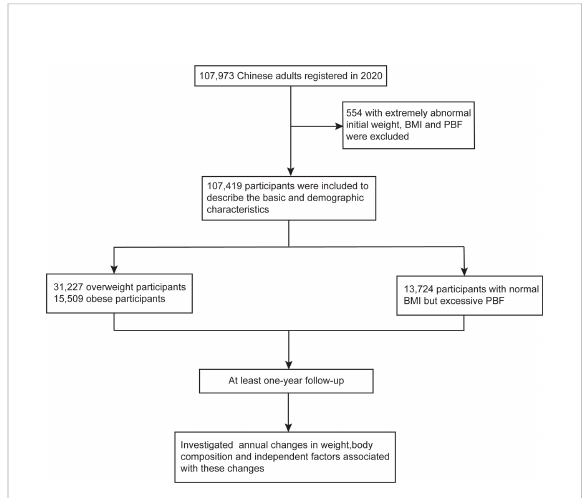
FIGURE 1 Flowchart of participant inclusion. BMI, Body Mass Index; PBF, Percentage of Body